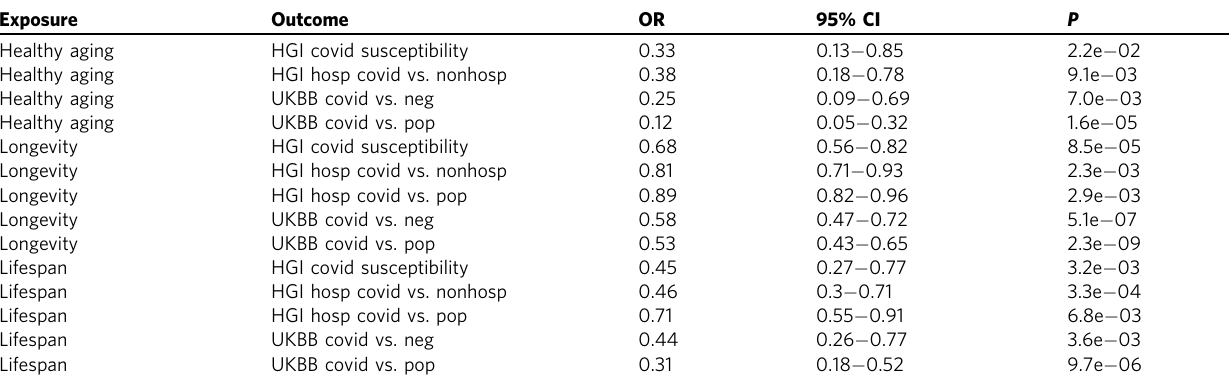
Table 1 Mendelian randomization estimates for the association between lifespan-related traits and risk of COVID-19.